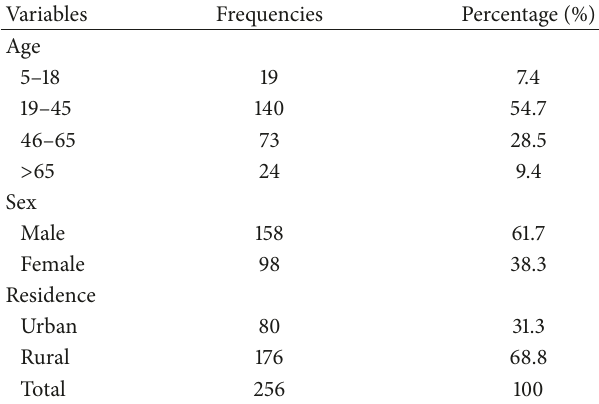
Table 1: Sociodemographic characteristics of PTB suspected patients at University of Gondar Hospital, Ethiopia, 2017.